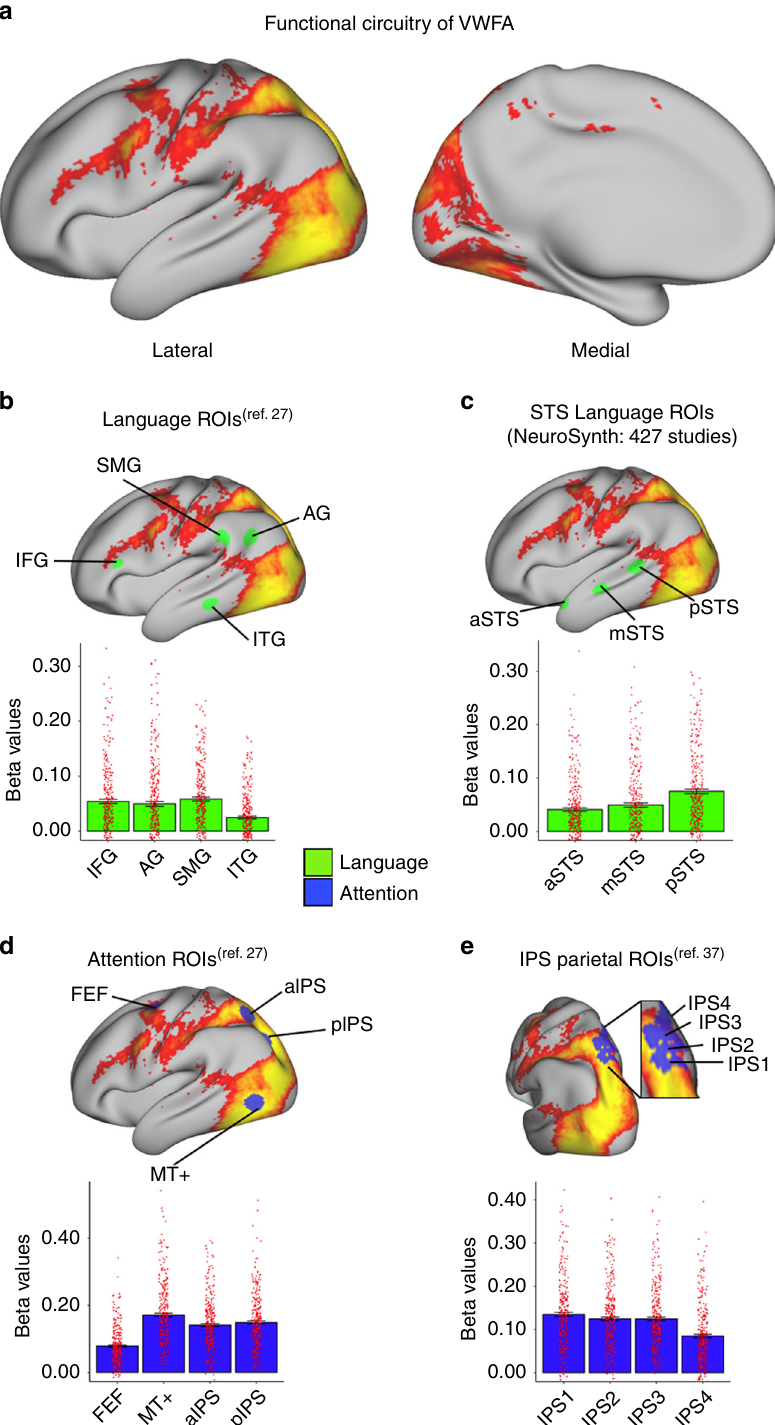
Fig. 3 Intrinsic functional connectivity of VWFA. a Thresholded map showing intrinsic functional connectivity of VWFA seed ( p < 10 − 40 ) in the whole sample ( N = 313). b Averaged beta values within targeted ROIs in the language network (IFG, SMG, AG, and ITG) selected from Vogel et al. 27 . c Averaged beta values within anterior, middle, and posterior sections of STS selected based on 427 studies from NeuroSynth with the key word “ reading ” . d Attention- related networks (FEF, aIPS, pIPS, and MT + ) selected from Vogel et al. 27 . e Averaged beta values within the retinotopic ROIs within IPS (IPS1-4) identi fi ed in Swisher et al. 37 . Error bars in the graph represent the standard error of means. Red dots on each bar represent individual data